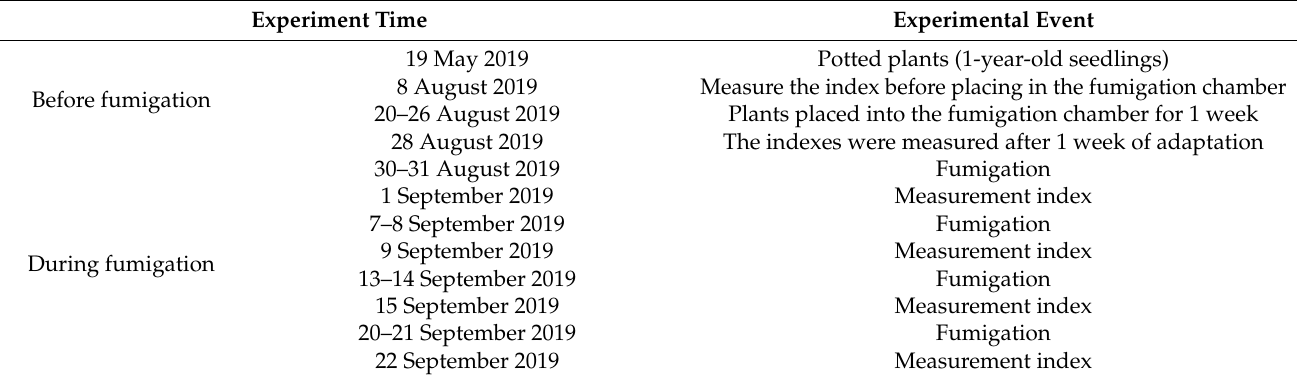
Table 2. Schedule of SO 2 stress experiments in